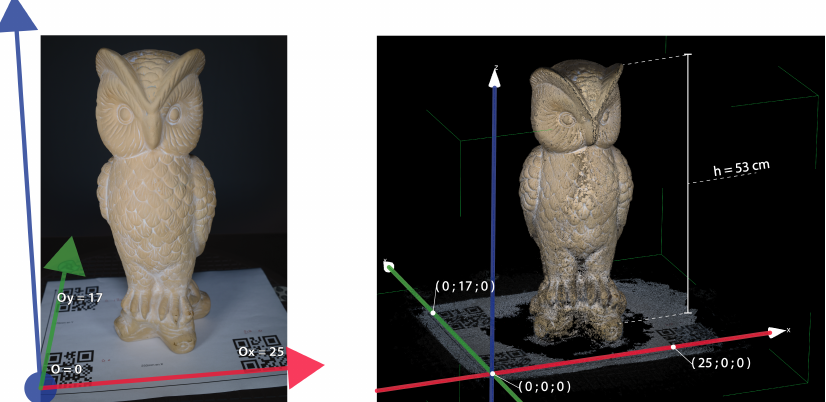
Figure 3. Owl dataset : example of QR-code triplet based global orientation and scaling.